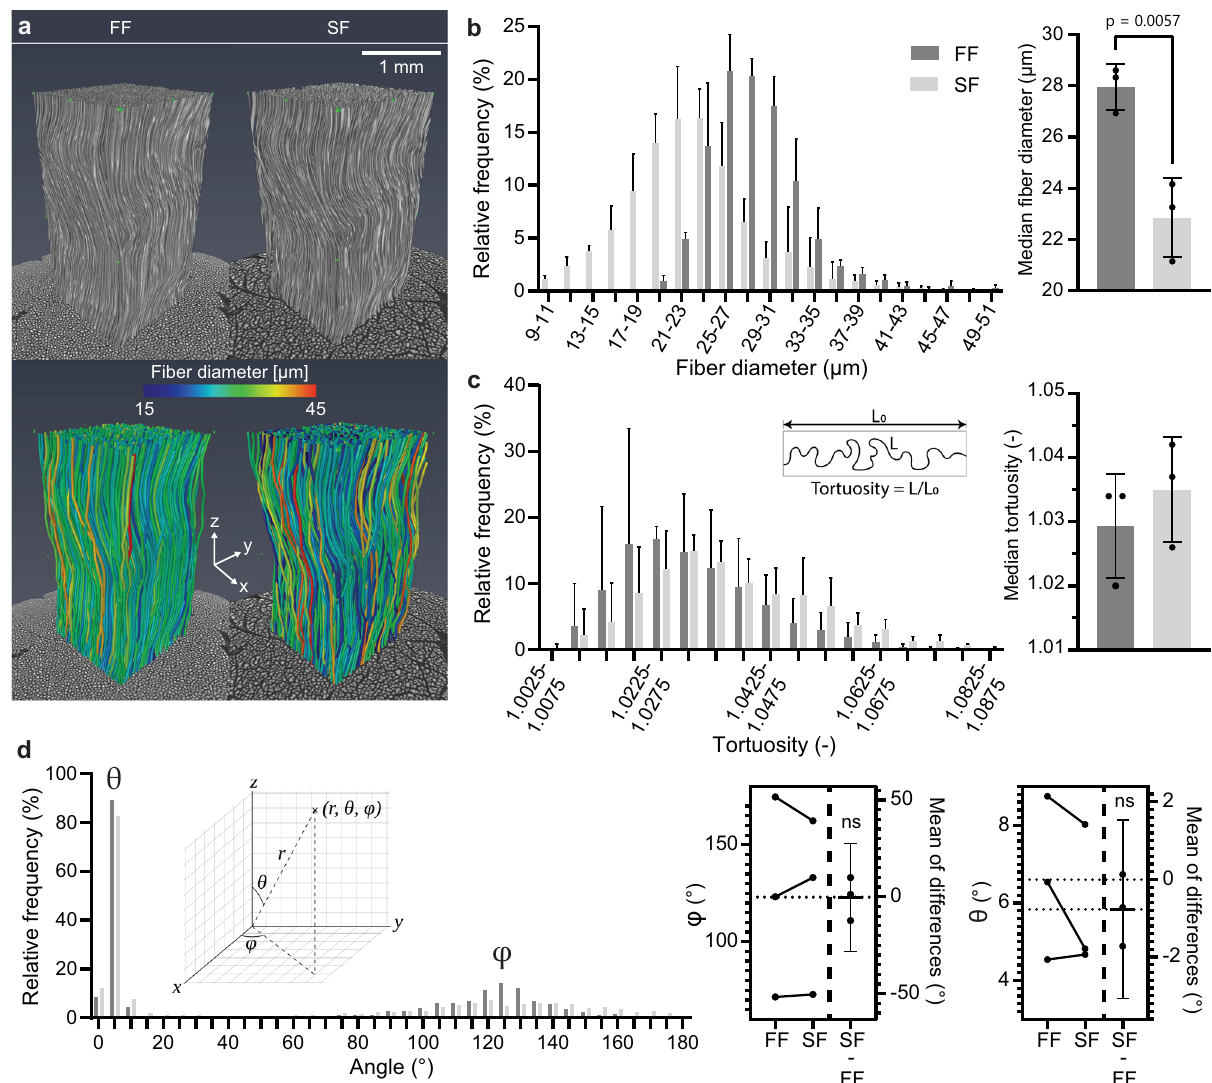
Fig. 2 | Quanti fi cation of the effect of different freezing rates on the micro- structure of bovine muscle tissue. a The fi brous microstructure of muscle tissue stained with Hf-WD POM and visualized with cryo-CECT both after fast freezing by submersion in isopentane at − 78°C (FF) and slow freezing in air at − 80°C (SF). On top, a volume rendering shows the VOI used for the structural analysis. Below, the fi ber model is shown, in which the diameter of each fi ber is indicated by the color scale. b Averagehistogramofthe fi berdiameter(left)andbargraphcomparingthe median fi ber diameter (right) after FF and SF. c Average histogram of the fi ber tortuosity (left) and bar graph comparing the median fi ber tortuosity (right) after